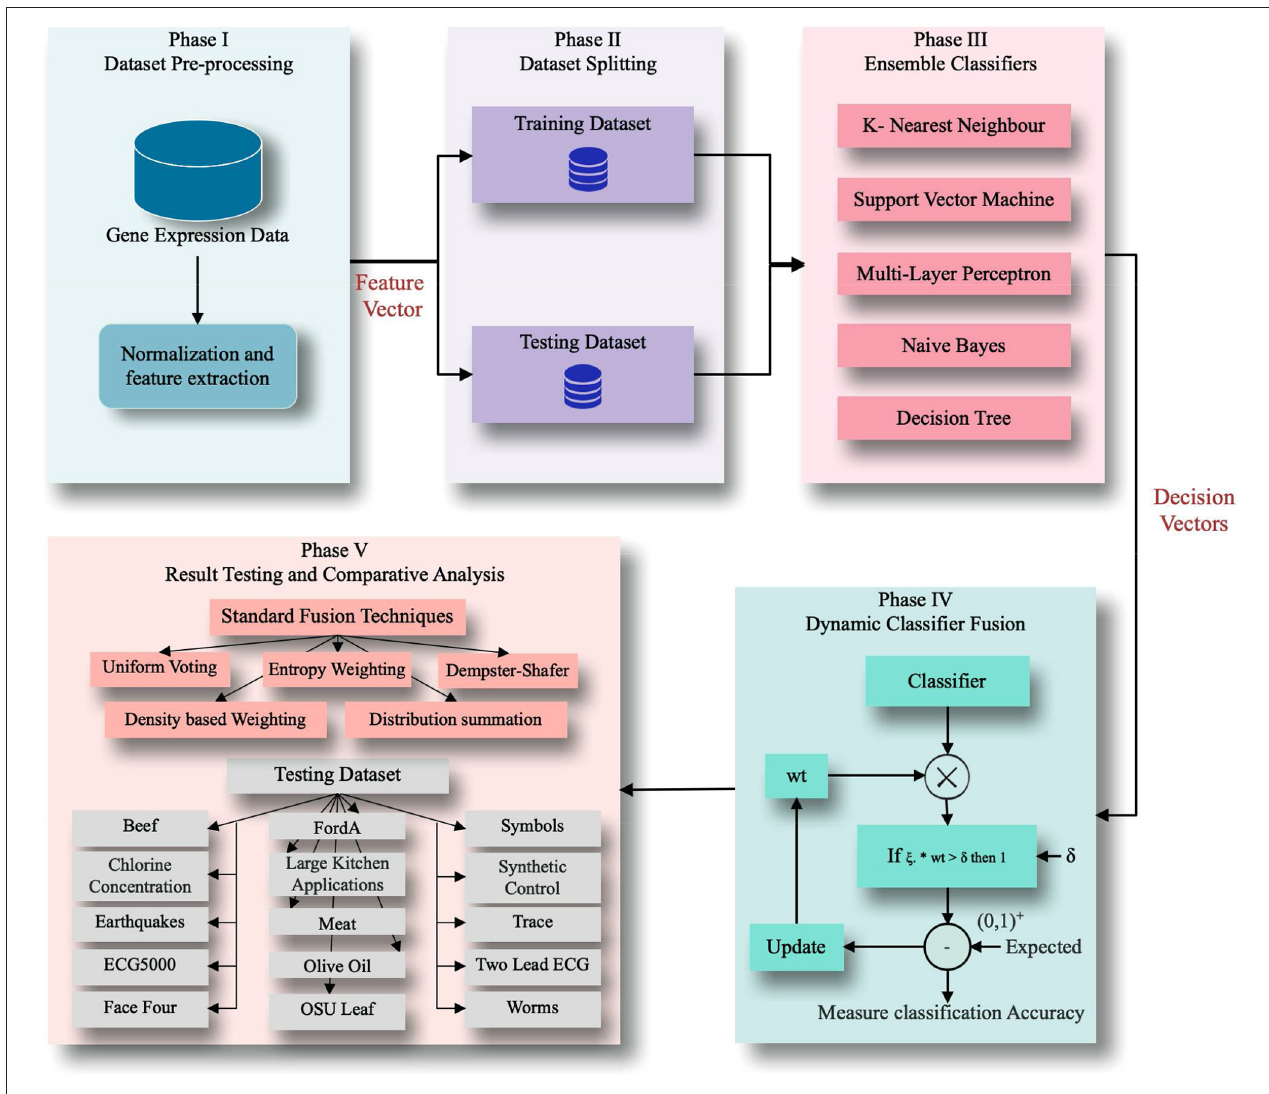
FIGURE 2 | Proposed